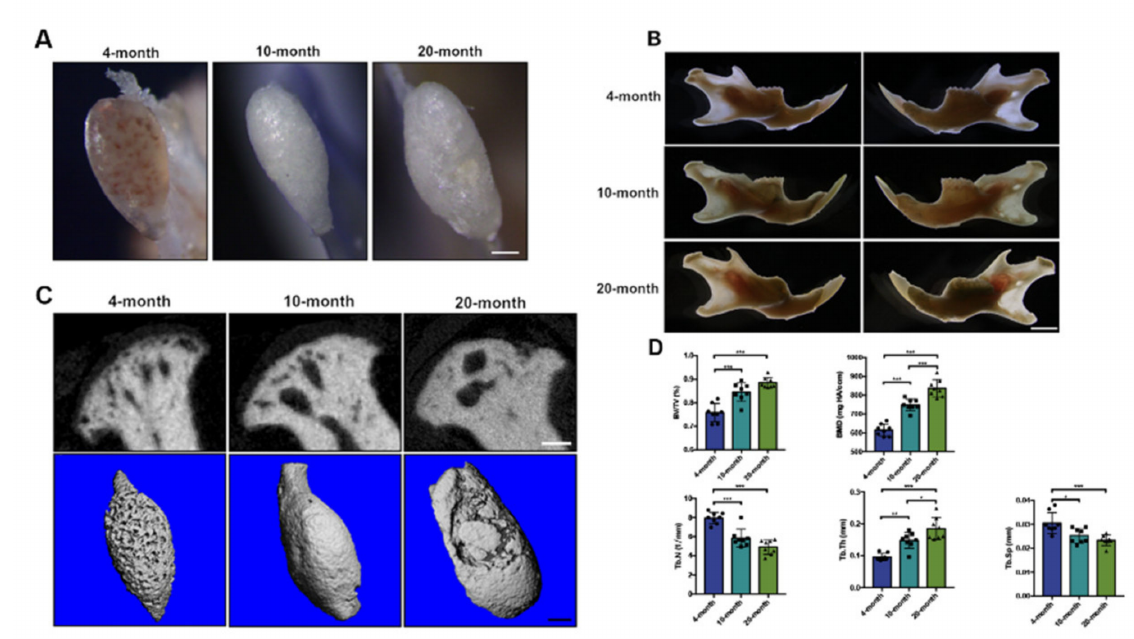
Figure 1. Osteochondral interface and subchondral bone of TMJ condyle gradually ossified with aging. ( A , B ) Microscope photographs of the mandibles and TMJ condyles in 4-month-old, 10-month-old, and 20-month-old mice. Scale bar: 200 µ m for data A and 1 mm for data B. ( C ) Representative 3D constructed and coronal-sectional images of TMJ condyles in different age groups. Scale bar: 200 µ m. ( D ) Quantitative micro-CT analyses on subchondral bone of TMJ condyles in different age groups. ( n = 8) * p < 0.05, ** p < 0.01, *** p <